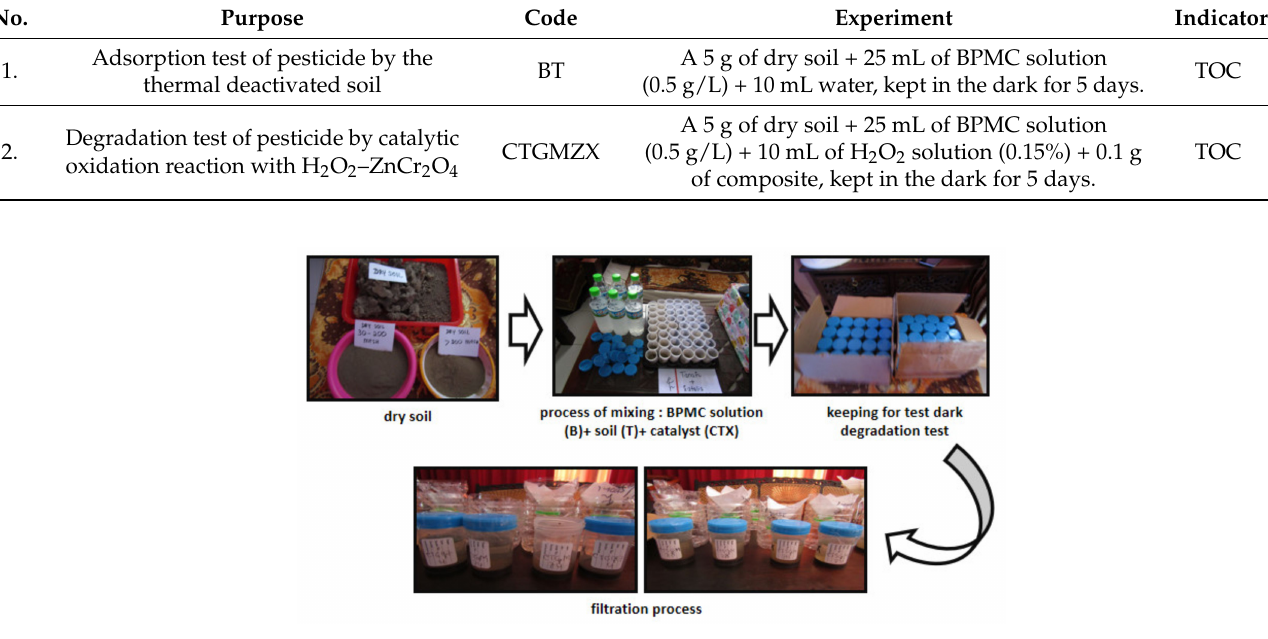
Figure 3. Process of pesticide (BPMC) dark degradation test.